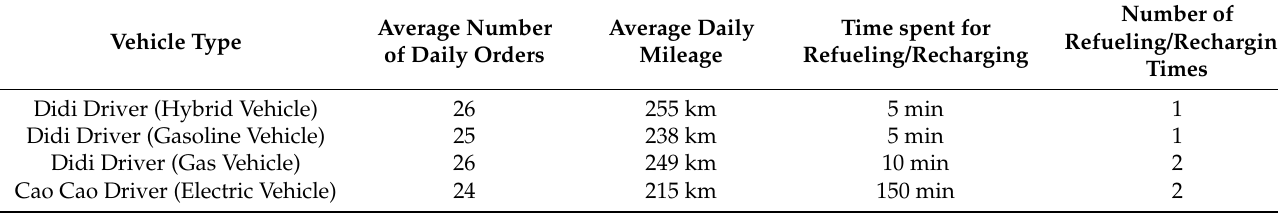
Table 10. Operating information of Didi and Cao Cao